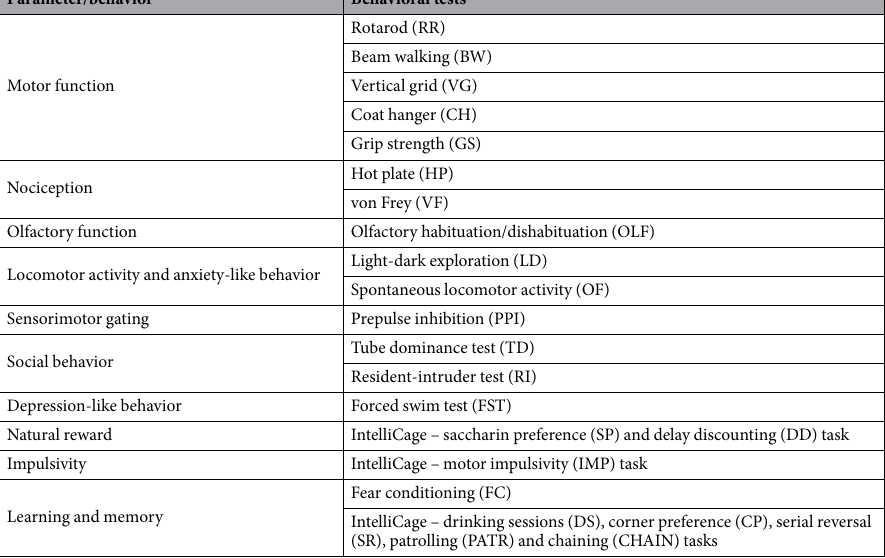
Table 1. Behavioral tests included in this